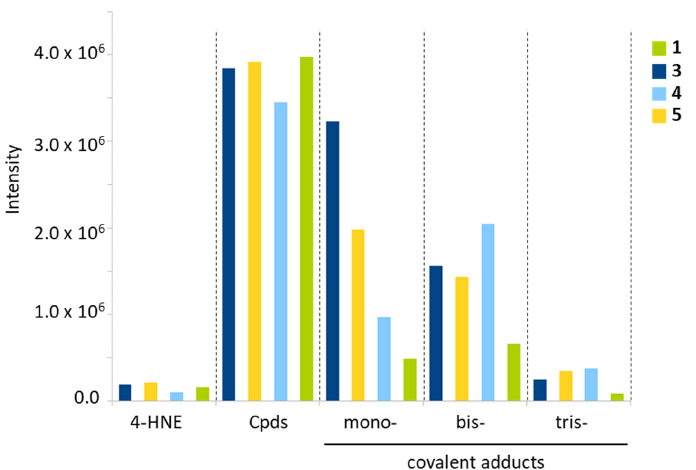
Figure 8. Relative proportion of the different species identified by HRMS upon reaction of 4-HNE with the indicated phenyl-pyrazolone derivatives. Columns marked “Cpds” refer to the unreacted compound. The mono-, bis-, and tris-adducts were detected by HRMS after 3 h of reaction in aqueous buffer (ammonium formate 5 mM buffer pH = 4.1 and methanol (60:40, v / v ), with stirring for 180 min at 37 °C).